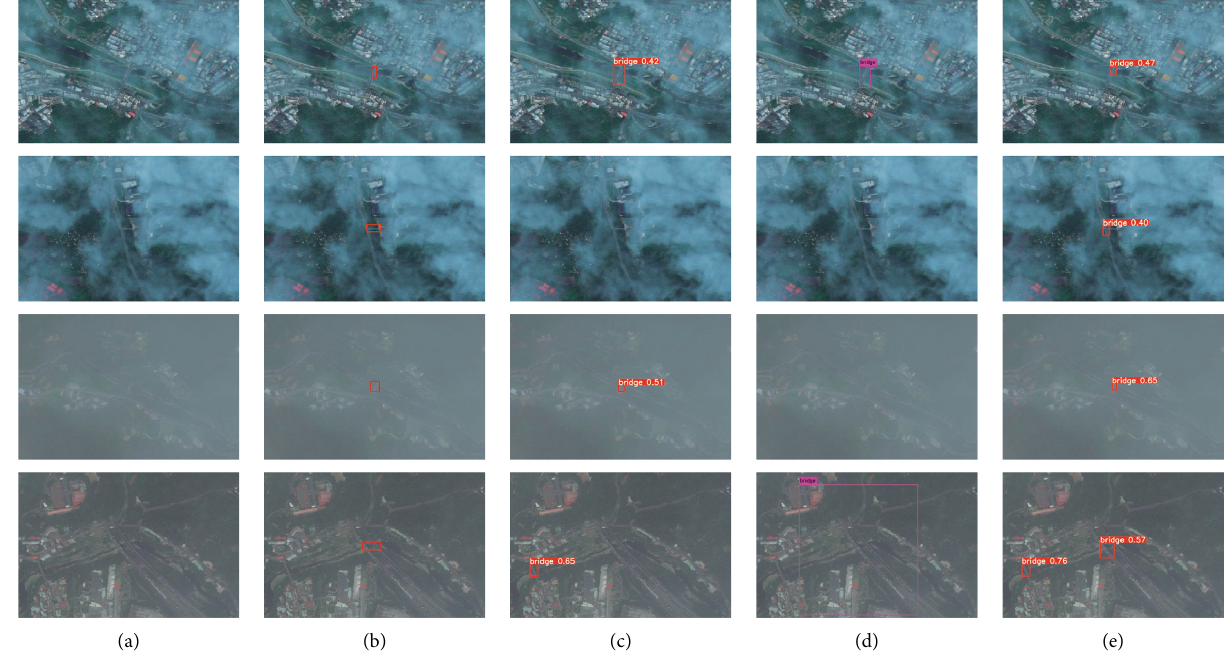
Figure 16: The comparisons of four different detection methods (i.e., (b) Faster R-CNN, (c) YOLOv3, (d) YOLOv4, and (e) YOLOv5s) for bridge detection under realistic hazy imaging scenarios. (a) Original. (b) Faster R-CNN, (c) YOLOv3, (d) YOLOv4. (e)